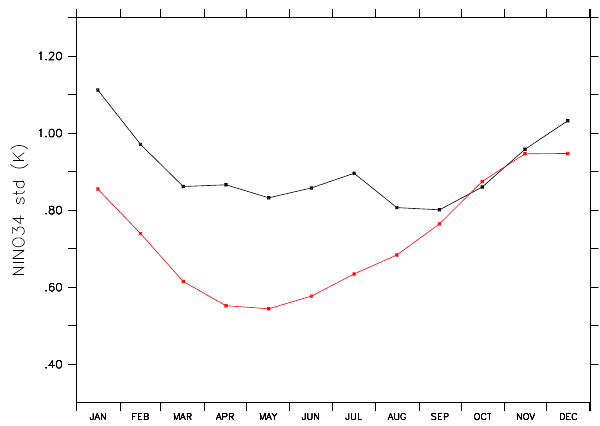
Fig. 9. Standard deviation of monthly mean inter-annual variability of the SST (in K) averaged over the NINO3.4 region. The black line shows results from the TRANS simulation, and the red line from the HadISST data (Rayner et al., 2003), both for the year 1900–1999 (not